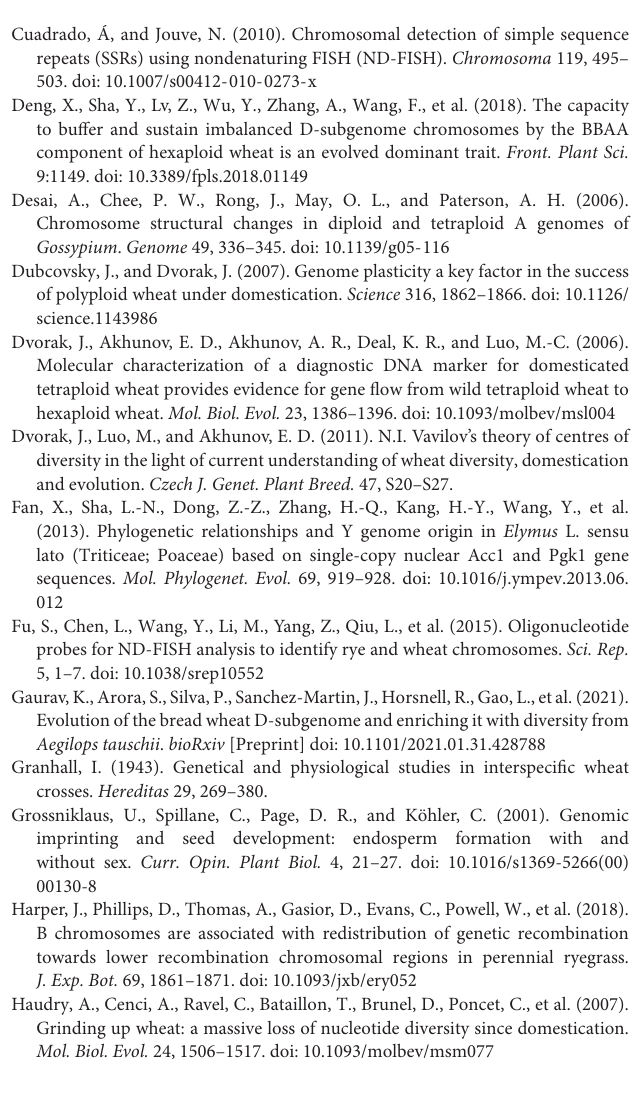
Supplementary Figure 1 | Physical distribution of polymorphic markers in the AB genomes of two sets of pentaploid-hexaploid populations. The purple circle indicated the centromere location. (A) Populations SPW1 and SHW1. (B) Populations SPW2 and SHW2.